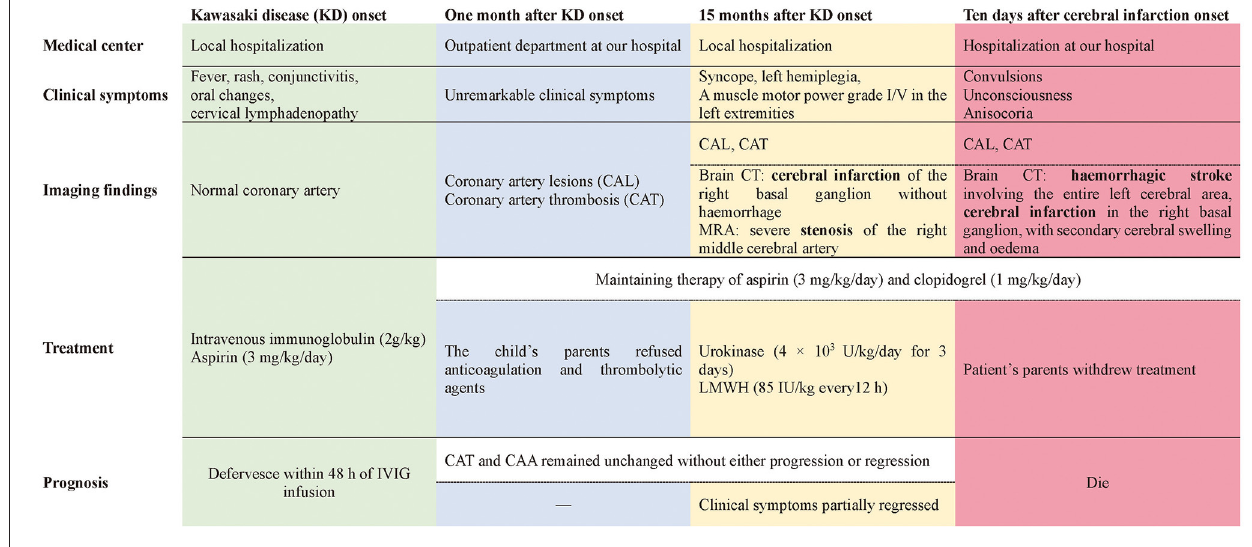
FIGURE 2 | Clinical course of this